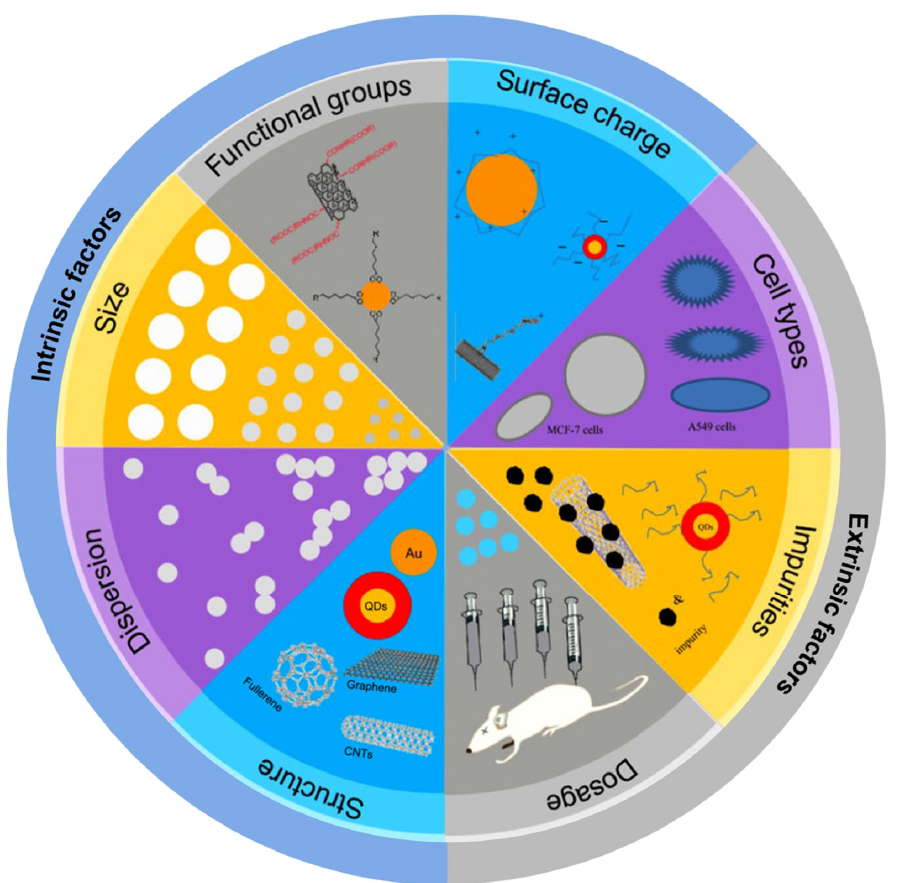
Figure 1. Intrinsic and extrinsic factors that can modulate the toxic effects of ENMs (reproduced and modified with permission from Zhao et al., ref. [20]. Copyright 2015, Elsevier).